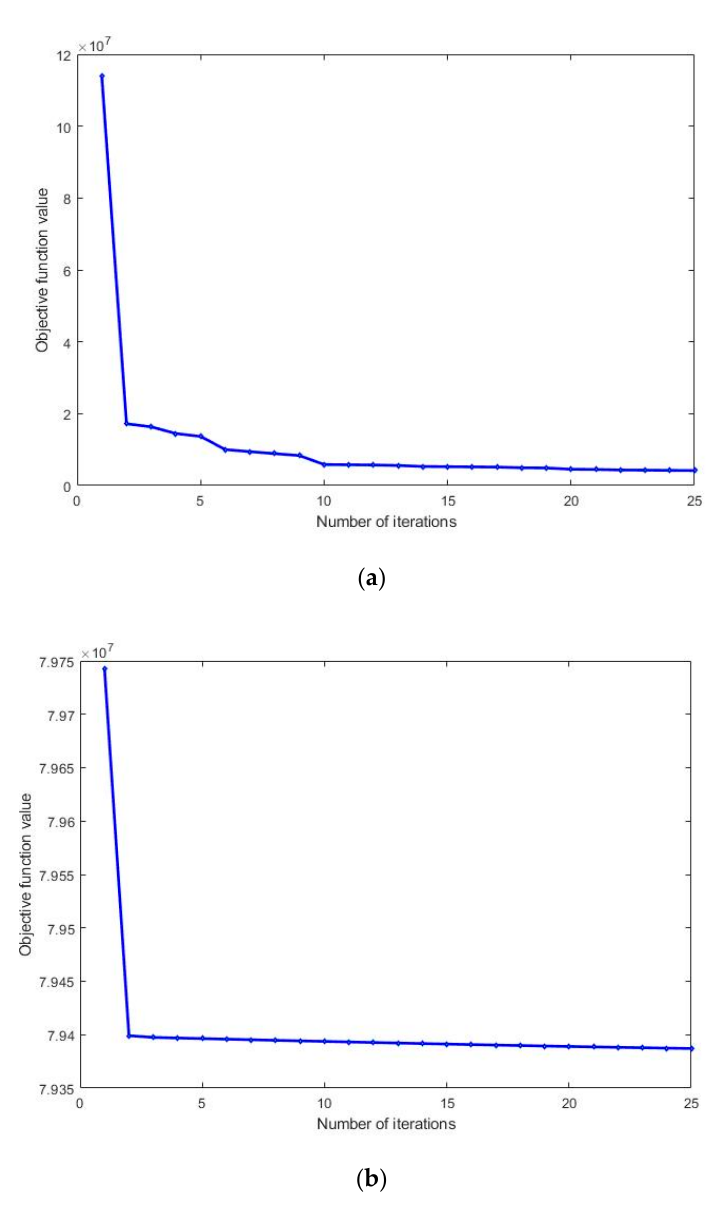
Figure 10. Convergence processes for Scene1 and Scene4 in subfigure ( a ) and ( b ).